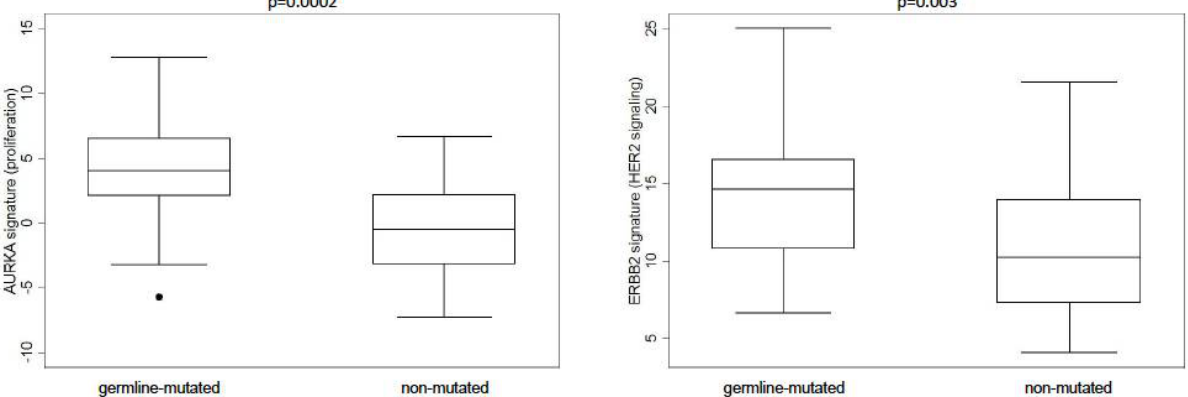
Figure 1. Gene-expression module signatures for key breast cancer biological processes were significantly different between germline-mutated and non-mutated MBCs.